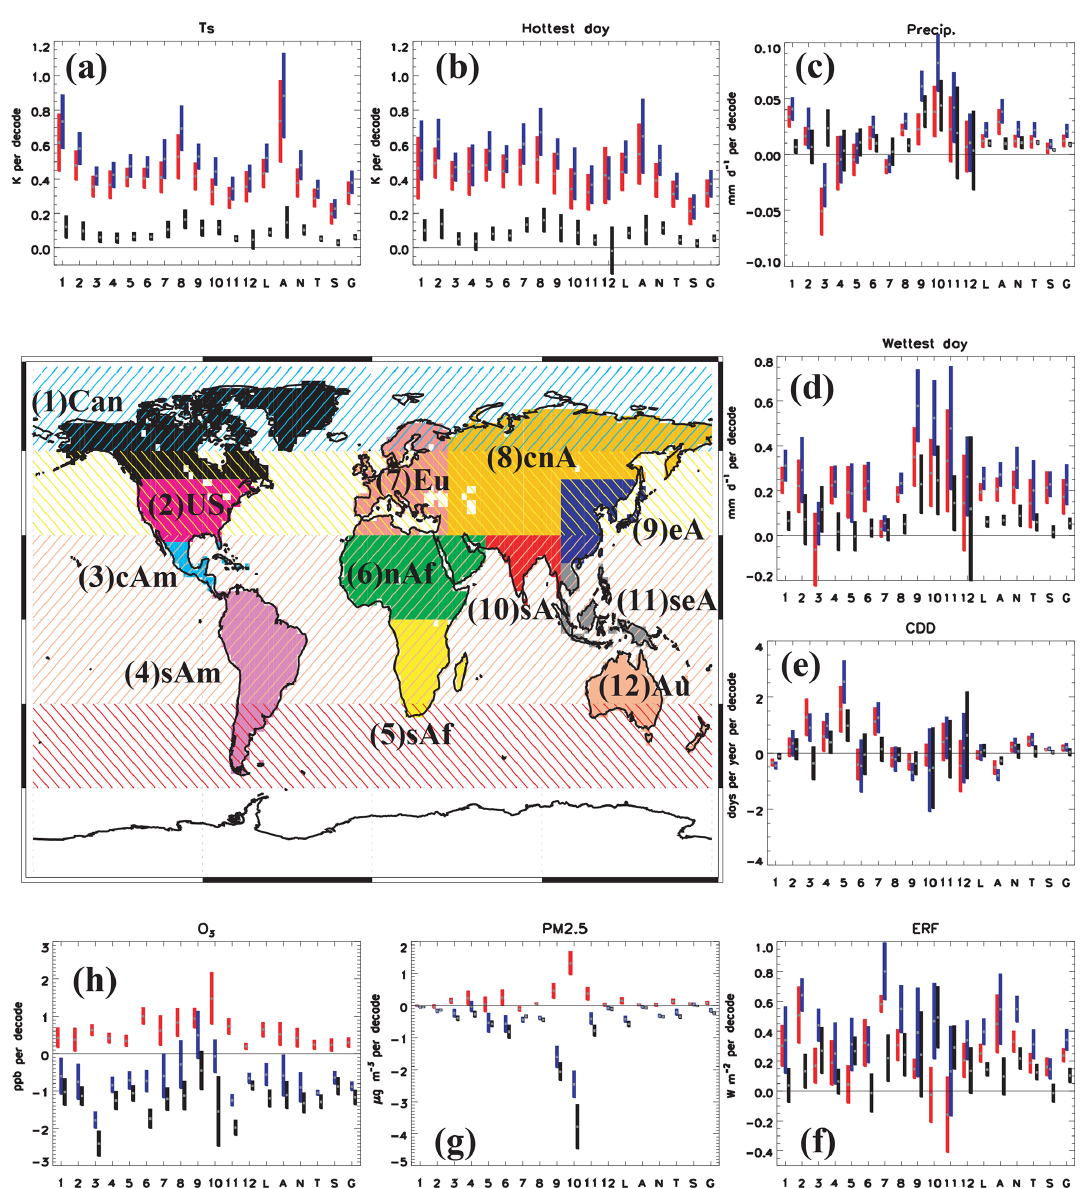
Figure 5. Regional climate and air pollution responses to NTCF mitigation. Bar plots show regional 2015–2055 trends in (a) surface tem- perature ( T s ); (b) hottest day; (c) precipitation (Precip); (d) wettest day; (e) CDDs; (f) ERF; (g) surface particulate matter (PM 2 . 5 ); and (h) ozone (O 3 ) for weak (red) and strong (blue) air quality control, and NTCF mitigation (black). Bar center (gray horizontal line) shows the multi-model mean trend, estimated as the average of each model’s mean trend. Bar length represents the 95% confidence interval, estimated √ n , where σ is the standard deviation of the individual model mean trends and n is the number of models. Center map shows the as 2 σ/ corresponding color-coded world regions for each bar plot (as in Fig. 2). The average over these 12 land regions is abbreviated as “L”. Also included is the Arctic (“A”; 60–90 ◦ N; light blue hatched region); NH midlatitudes (“N”; 30–60 ◦ N; yellow hatched region); tropics (“T”; 30 ◦ S–30 ◦ N; beige hatched region); SH midlatitudes (“S”; 60–30 ◦ S; red hatched region); and the global mean (“G”). Trend units are Kdecade − 1 for T s and hottest day; mmd − 1 decade − 1 for Precip and wettest day; µgm − 3 decade − 1 for PM 2 . 5 ; ppbdecade − 1 for O 3 ; days per yeardecade − 1 for CDDs; and Wm − 2 decade − 1 for